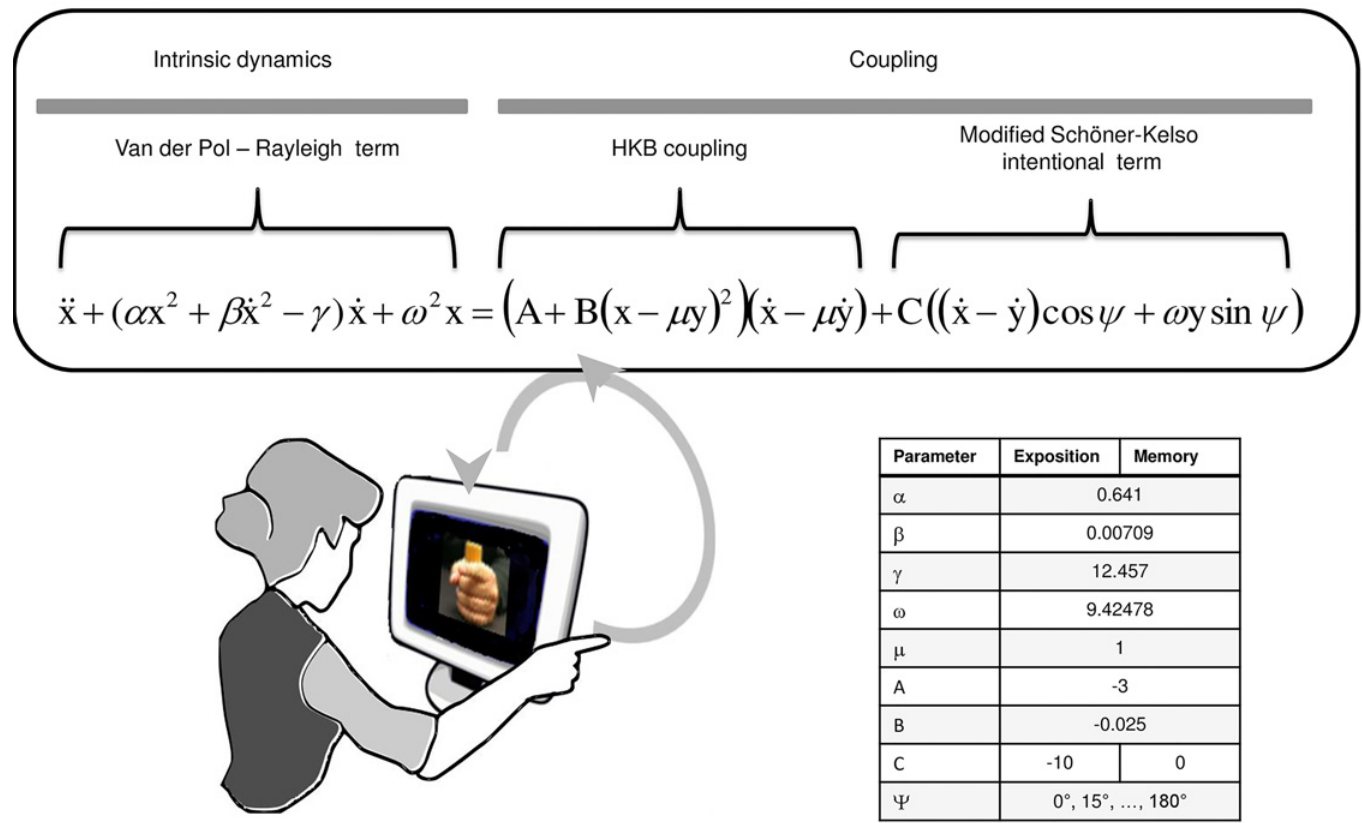
Fig 2. Virtual Teacher setup. The current finger position of the human participant is sent to a model governing the current finger position of the VT. In an Exposition period of the experiment, the VT is programmed to coordinate with the participant so that a relative phase specified by the VT ( Ψ ) is eventually co- produced. In a Memory period, the modified Schöner-Kelso intentional term of the VT is set to 0°, whereas the HKB coupling term is set either to nonzero (Experiment 1) or to zero (Experiment 2). See text for details.